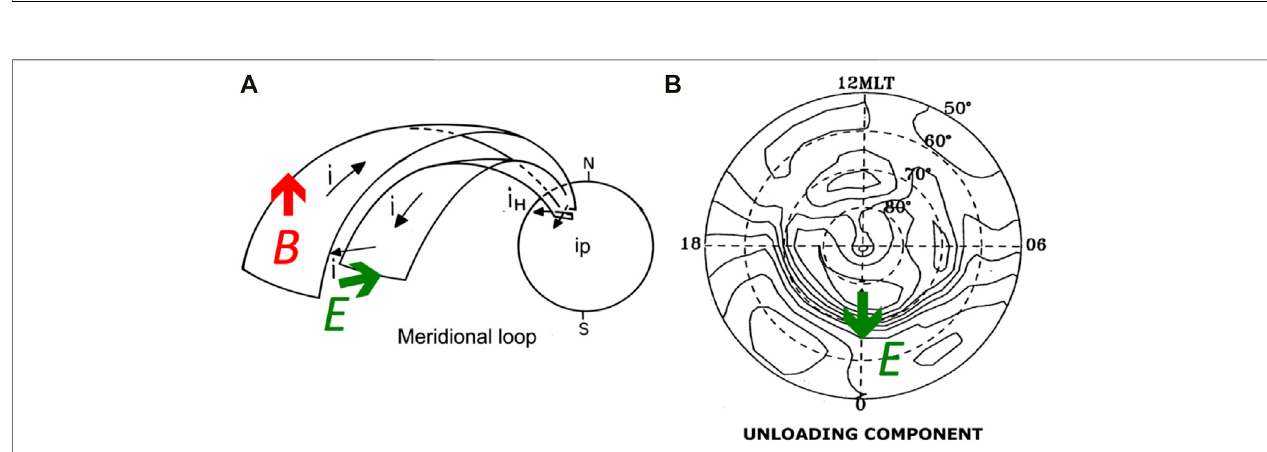
FIGURE 16 | (A) Bostrom ’ s 3-D current system for the expansion phase. (B) The UL current in the ionosphere deduced on the basis of the six meridian chains of magnetometers. The earthward electric fi eld becomes a southward (equatorward) electric fi eld E